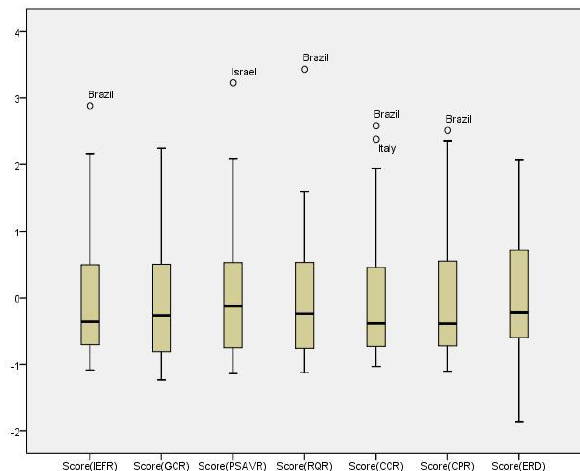
Figure 3. Bloxpot of the Macroeconomic Variables of the 30 Most Innovative Countries and Brazil for